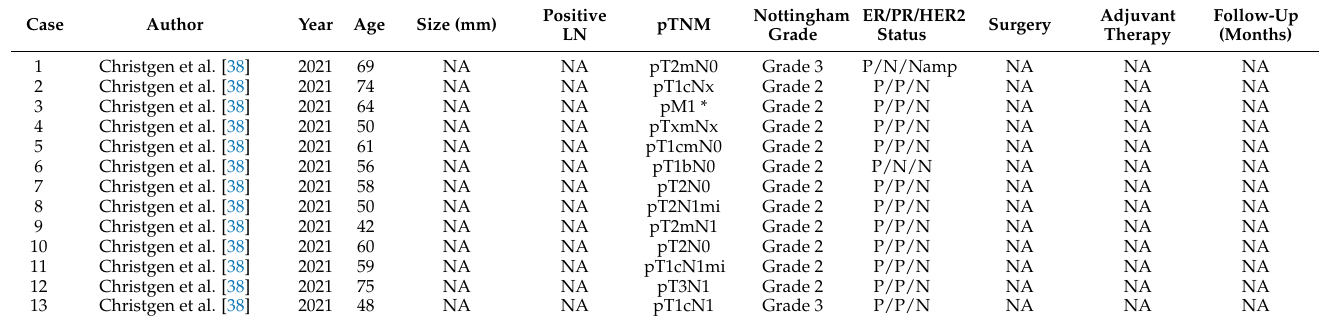
Table 3. Clinicopathological findings of invasive lobular carcinoma with tubular